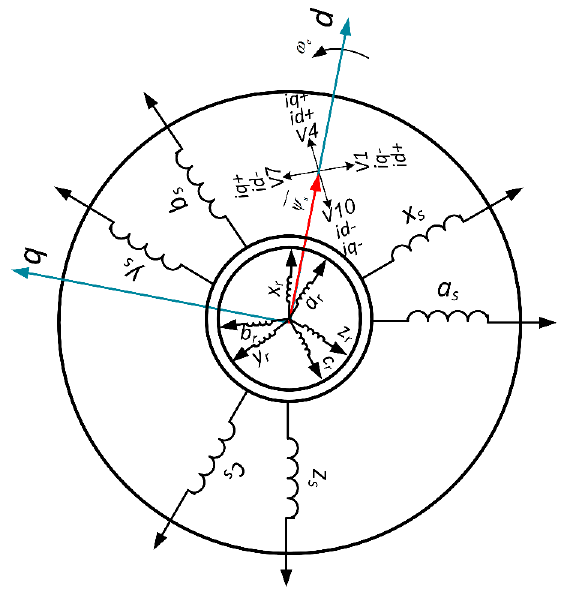
Figure 5. 6PIM structure and stator flux vector in 3rd sector and applied inverter voltage vectors.